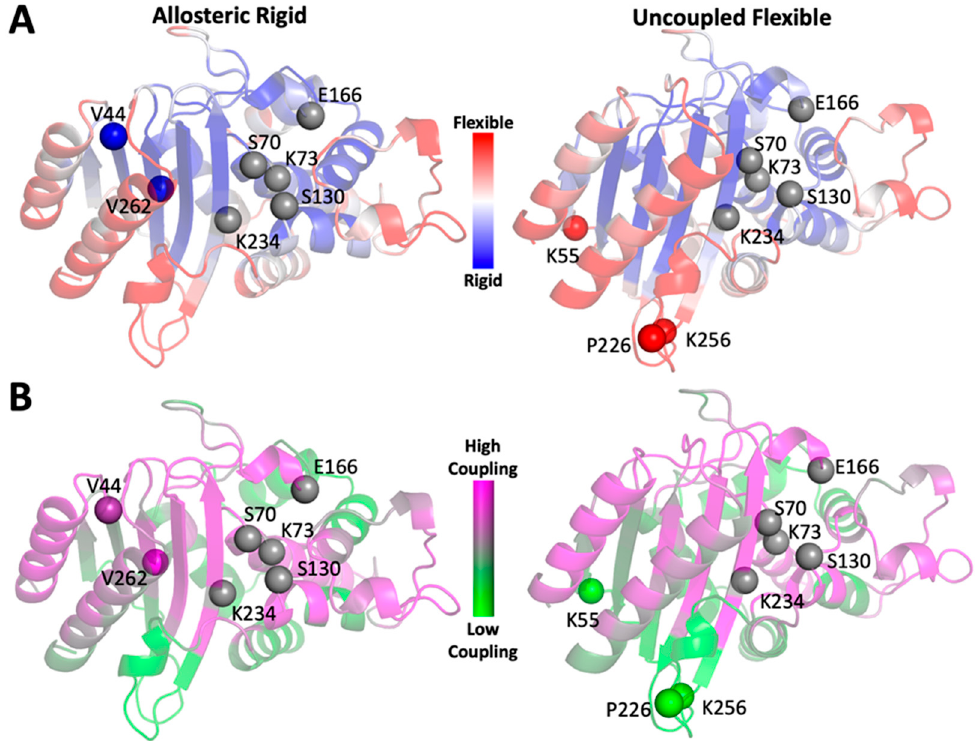
Figure 2. The dfi ( A ) and dci ( B ) values of each residue in TEM-1 are calculated and mapped onto the structure of TEM-1, which is shown as color coded cartoons. Catalytic residues are shown as grey spheres. Rigid and flexible residues used in this study are shown as spheres that are colored by either their dfi ( A ) or dci ( B ) score. Allosteric rigid residues, V44 and V262, have low dfi scores and high allosteric dynamic coupling with the active site residues. Residues K55, P226, and K256 are both highly flexible and exhibit low allosteric dynamic coupling to the active site.